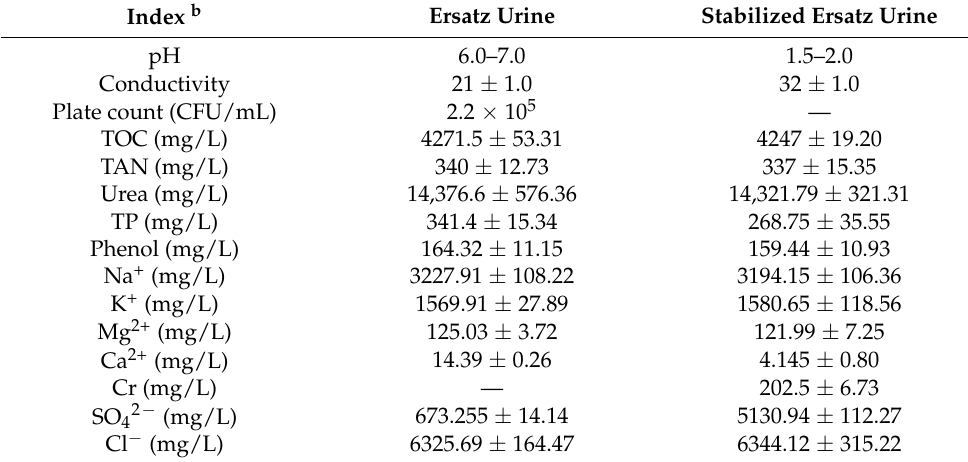
Table 1. Data on fresh and stabilized ersatz urine a